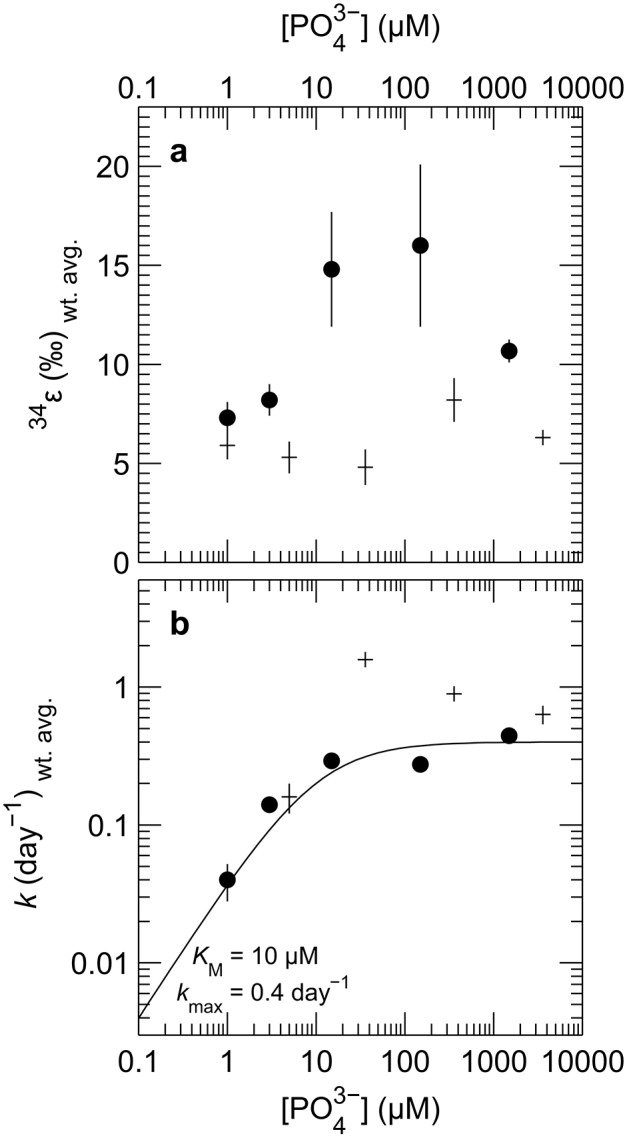
Plot of weighted mean (a) isotope fractionation (34ε) and (b) growth rate (k) for batch cultures of D. inopinatus (•) and DMSS-1 (+) grown on lactate at different initial concentrations of phosphate. Data from individual bottles were weighted by 1/σ2. Vertical error bars are 1σ for the weighted means, calculated following Bevington and Robinson (2002). Points corresponding to experiments in which phosphate was <1 μM are plotted at 1 μM. Data for DMSS-1 grown in 3,600 μM phosphate are from Sim et al. (2011b). The curve in (b) is a fit of the Monod equation (see Equation 7) (Monod, 1949), to the D. inopinatus data.